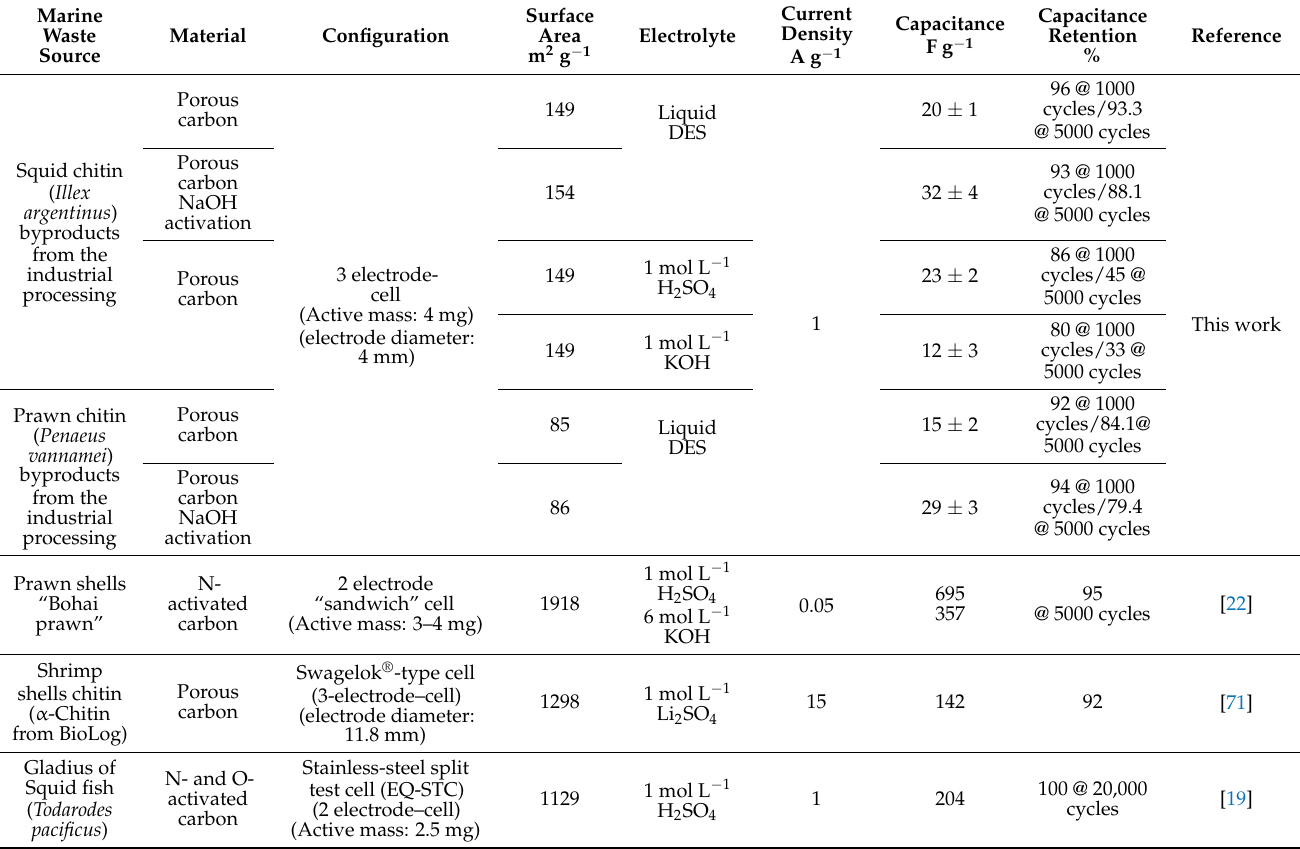
Table 8. Literature review of chitin-based porous carbon electrodes from fish/marine waste for